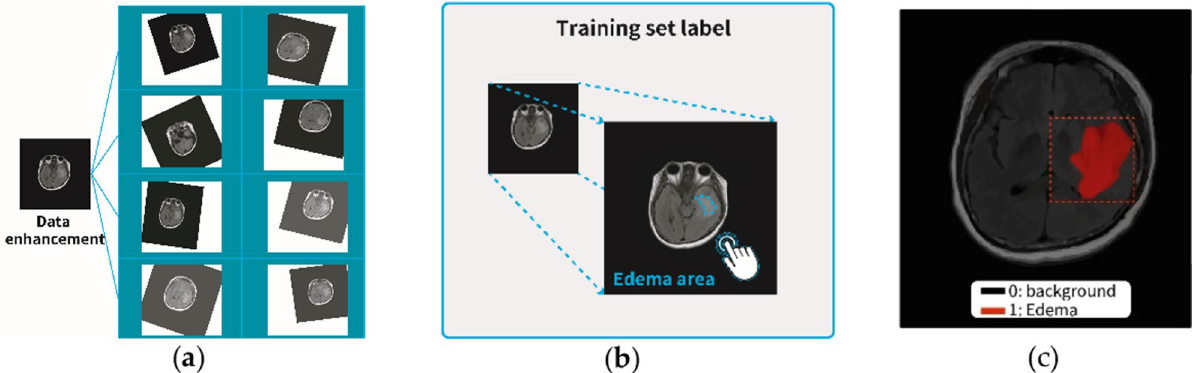
Figure 3. Data set construction and annotation. ( a ) Data enhancement technology. ( b ) Image annotation tool, Labelme. ( c ) Image marked with cerebral edema. Image source statement: This image was created using